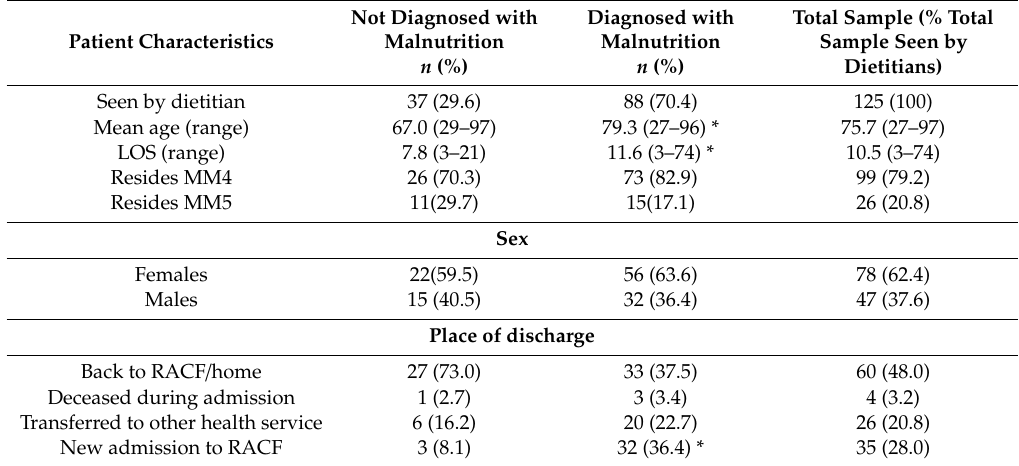
Table 3. Characteristics and comparison of patients seen by the dietitian by diagnosis of